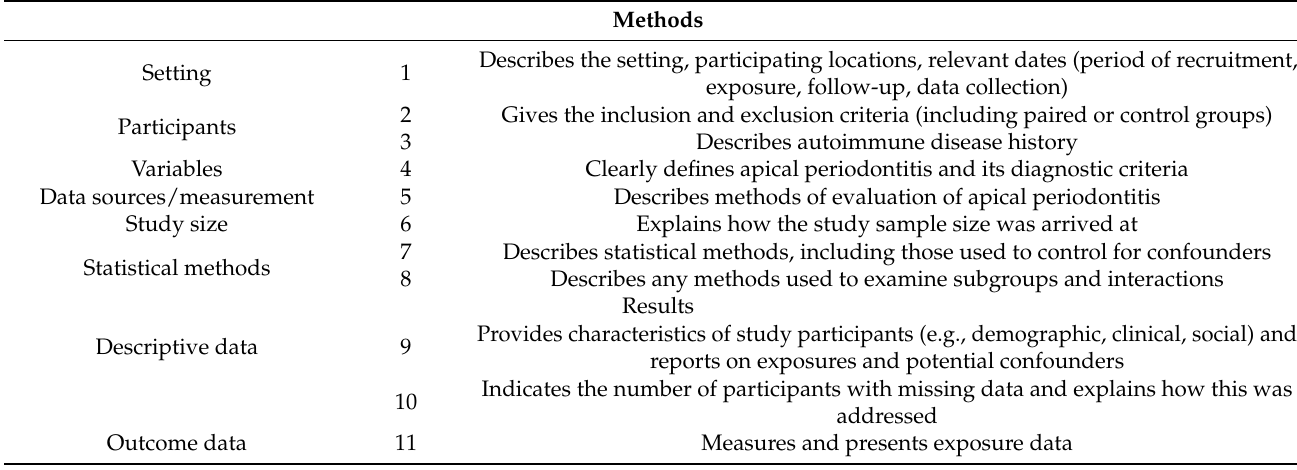
Table 6. Checklist of 11 criteria based on an adapted version of the STROBE guidelines for assessing the quality of observational studies.